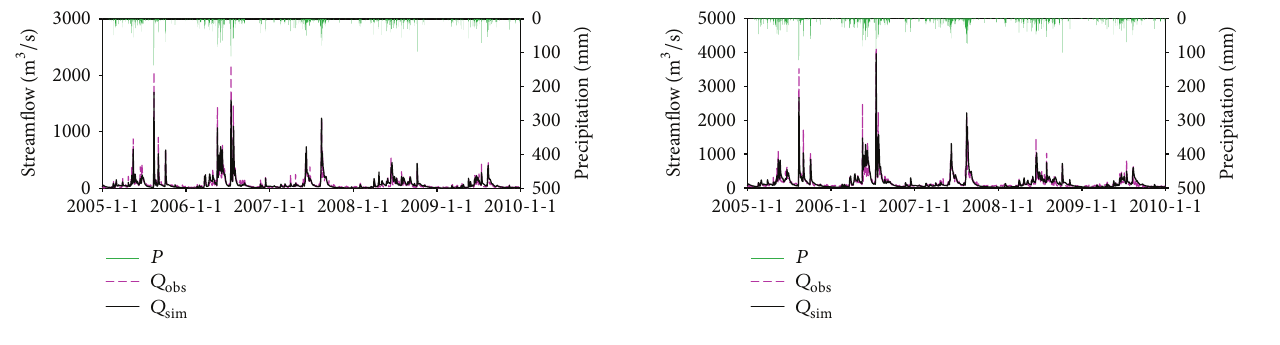
is simulated sim